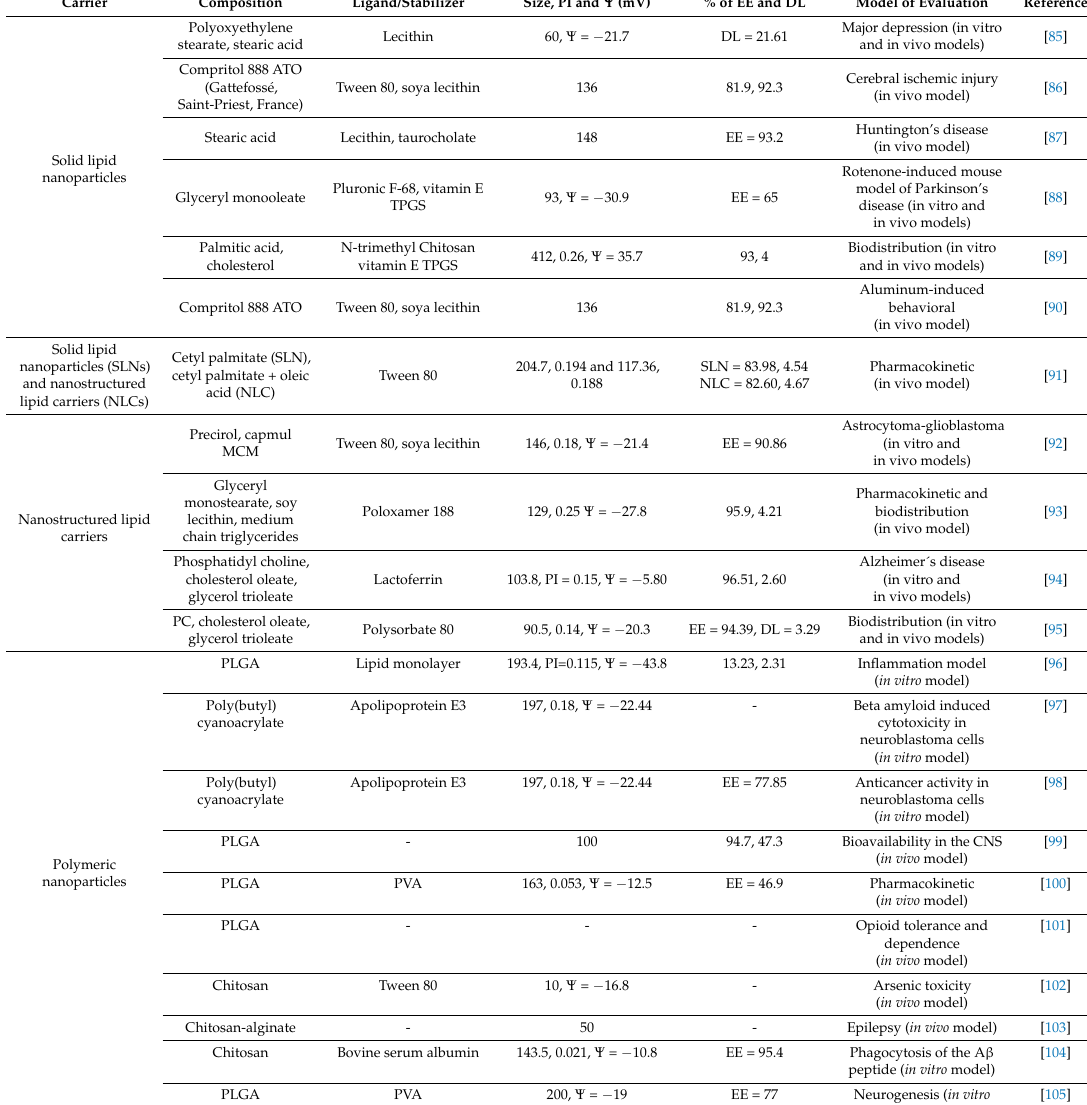
Table 1. Examples of nanoparticle formulation for transport of curcumin to the brain.